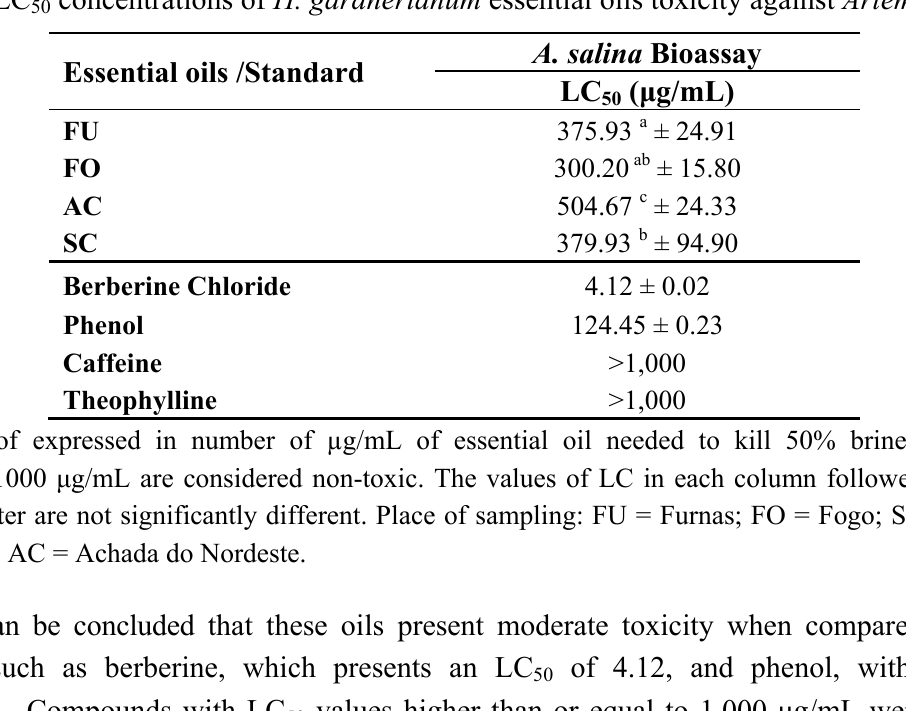
concentrations of H. gardnerianum essential oils toxicity against Artemia salina Table 4. LC 50